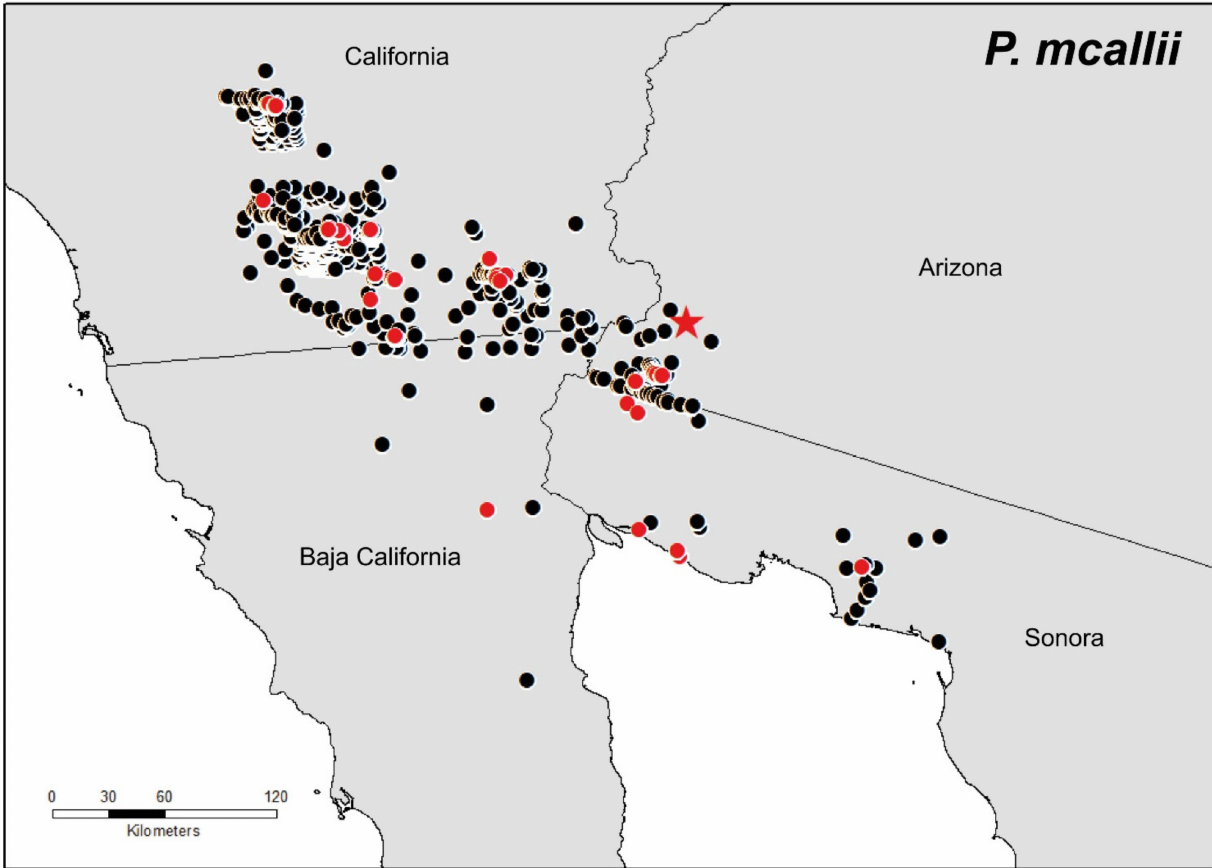
Figure 12. Map showing distributional records of Phrynosoma mcallii . Red circles = genetically confirmed records; black circles = records that have not been genetically confirmed; red star = type locality of P. mcallii . Content: No subspecies are